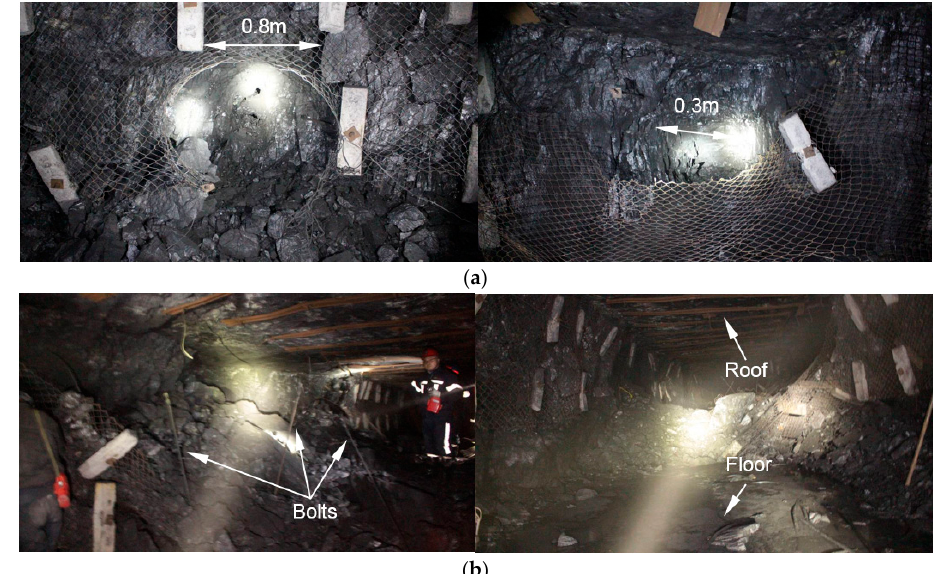
Figure 14. Degrees of damage to the coal rib under the two blasting conditions: ( a ) Apparent effect of